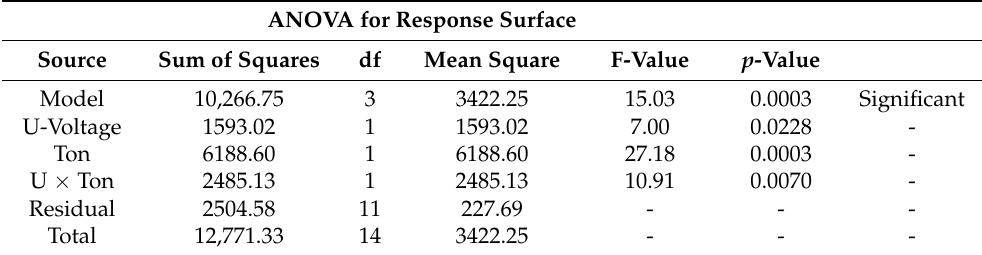
Table 6. ANOVA for the reduced 2-way interaction model. ANOVA for Response